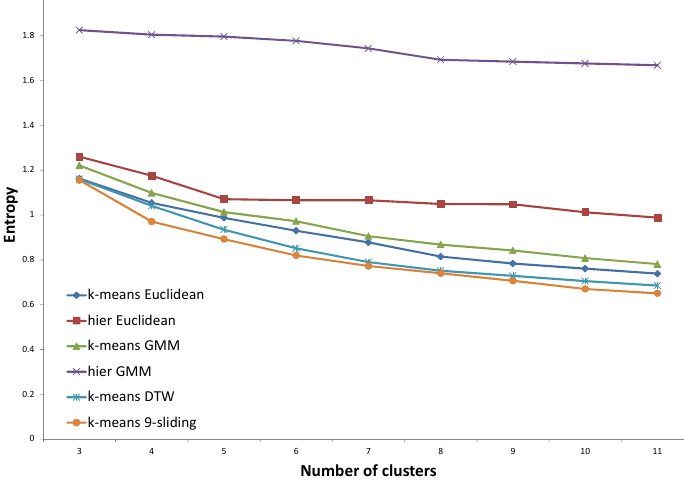
Figure 10. Entropy results for the northern part of Gyeonggi Province according to expert